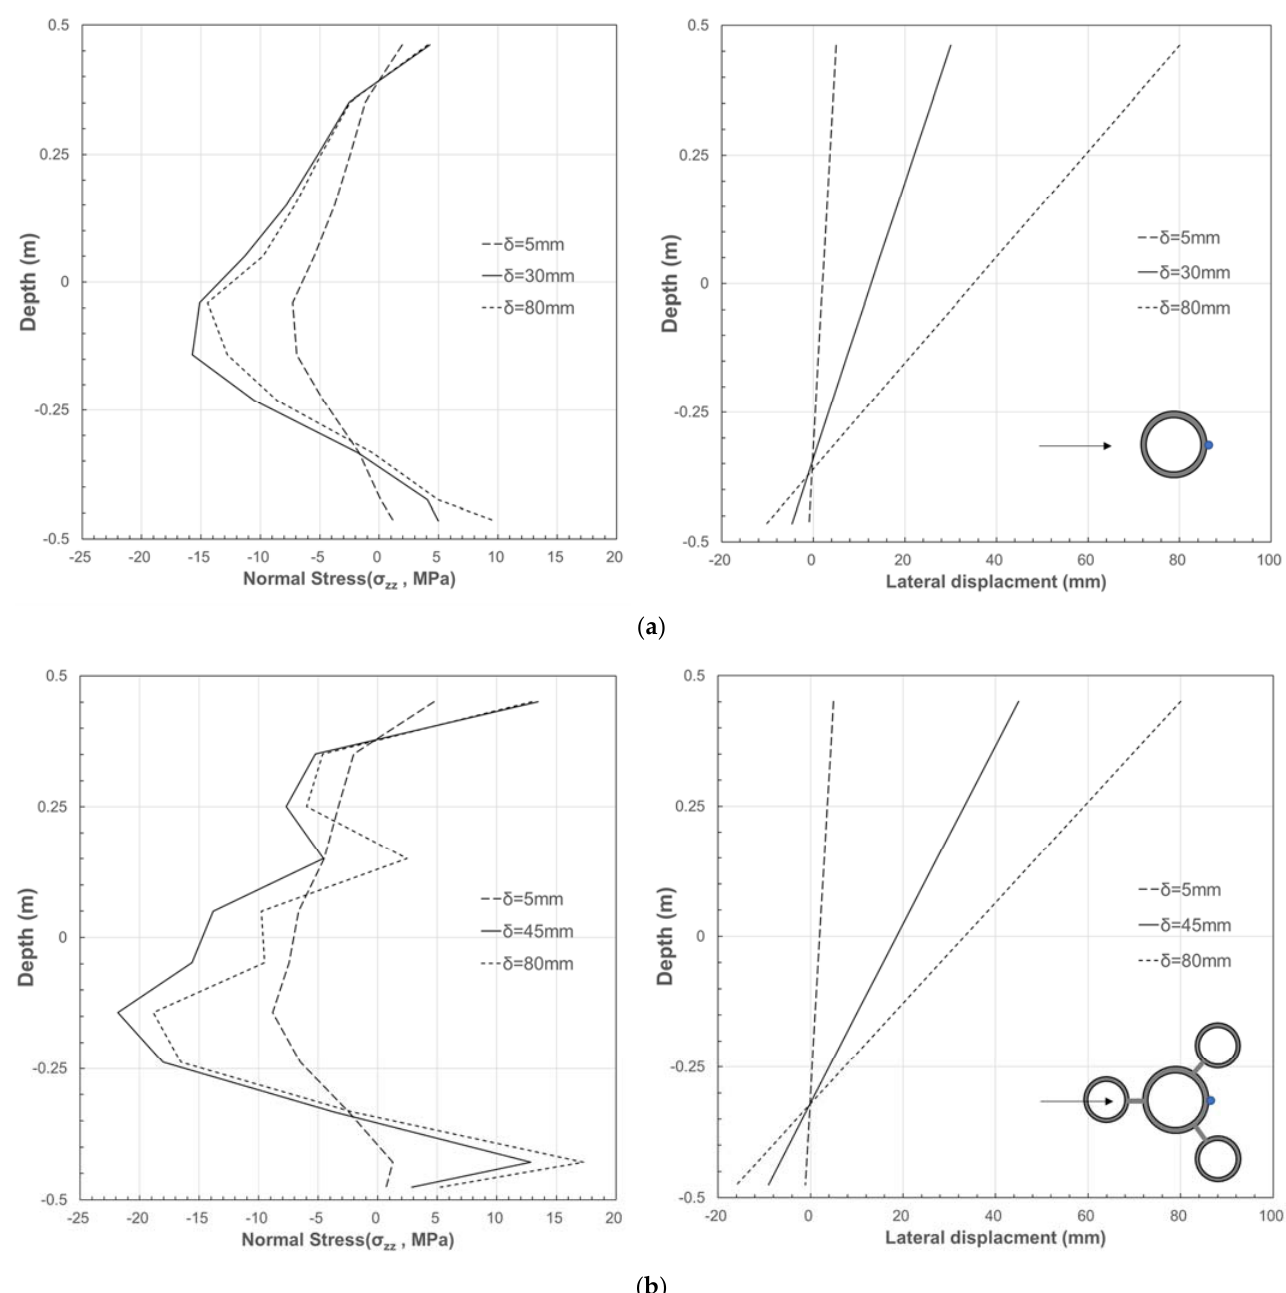
Figure 11. Normal stress ( σ zz ) and lateral displacement distribution profiles along monopiles: ( a ) monopile; ( b ) hybrid monopile; where each diagram on lower right corner of ( a , b ) indicates a cross-section of the conventional and the hybrid monopiles, respectively; black arrow: load direc- tion, blue point: observation